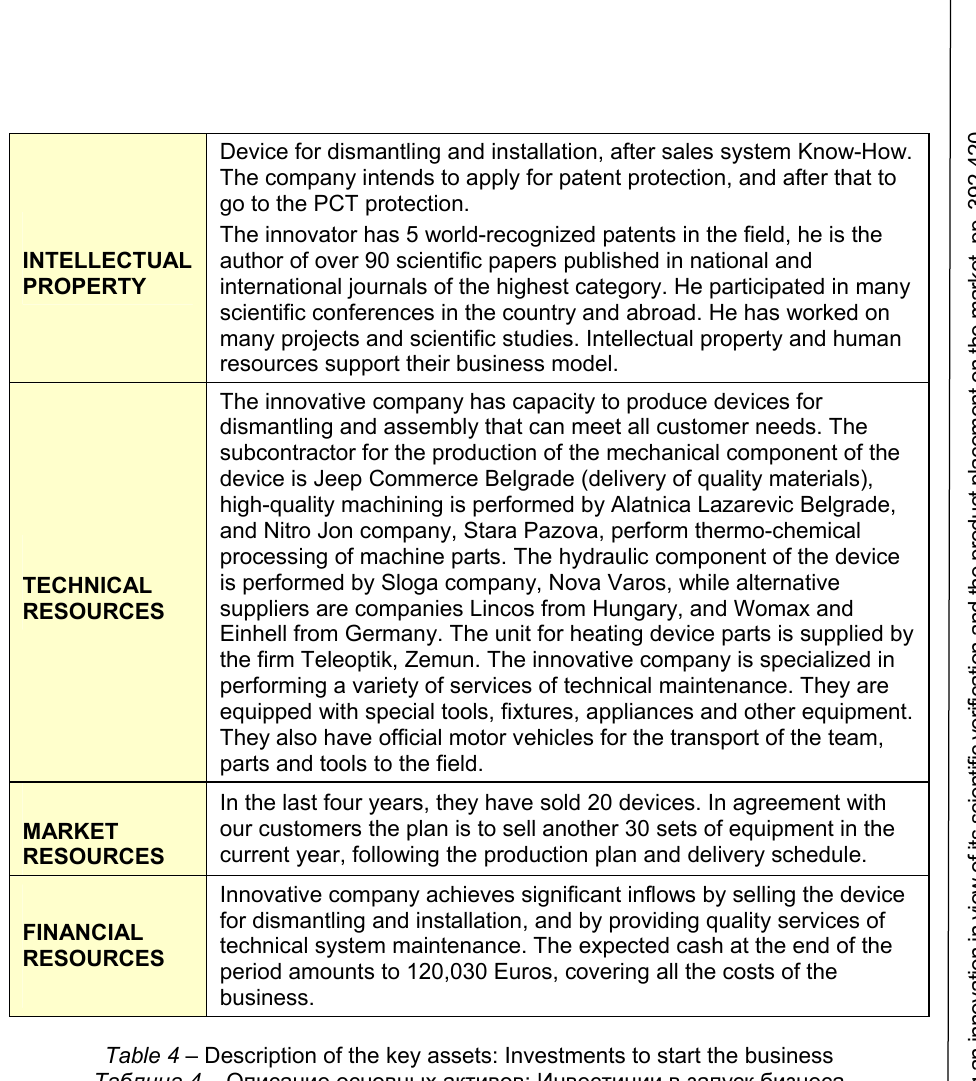
Table 4 – Description of the key assets: Investments to start the business Таблица 4 – Описание основных активов : Инвестиции в запуск бизнеса Табела 4 – Опис кључних ресурса : инвестиције за почетак пословања TYPE OF